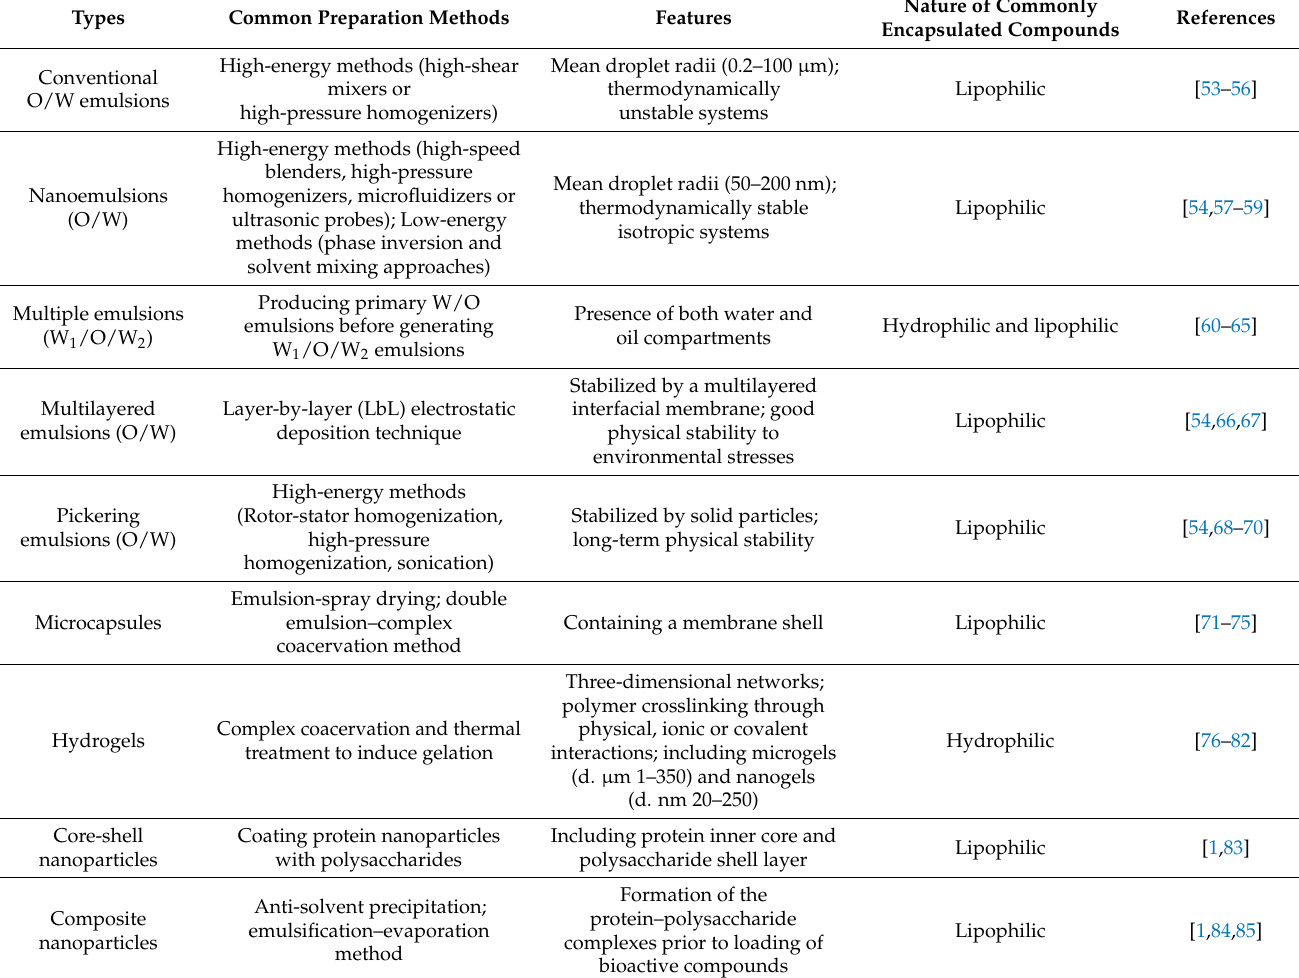
Table 2. Overview of protein–polysaccharide complex/conjugate-based delivery systems for bioac- tive